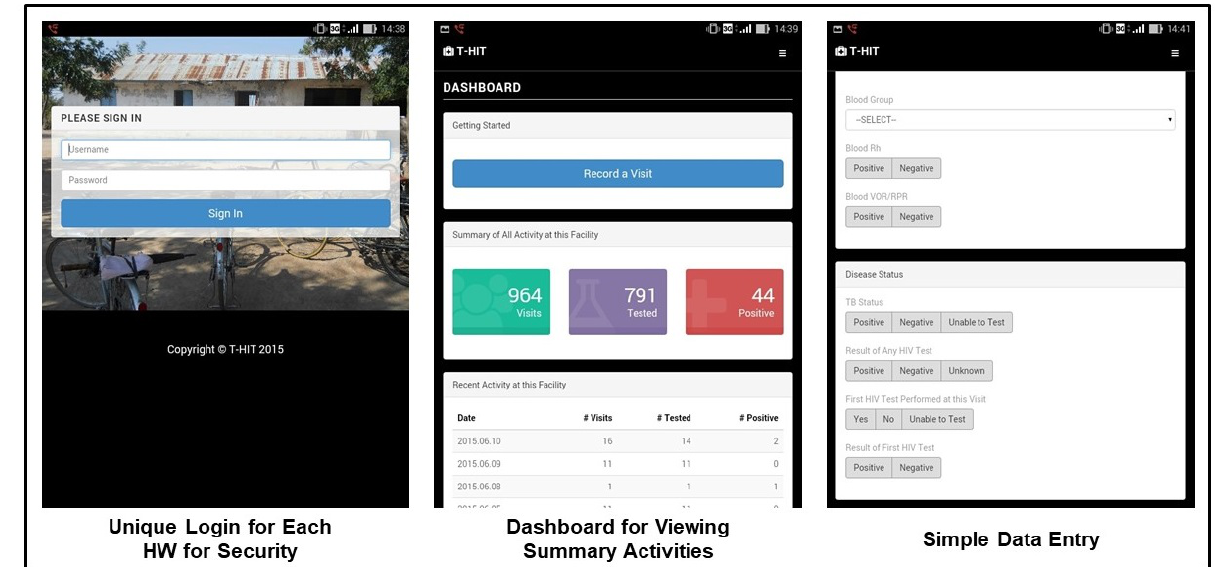
Figure 1. Selected screenshots of the Tanzania Health Information Technology (T-HIT)